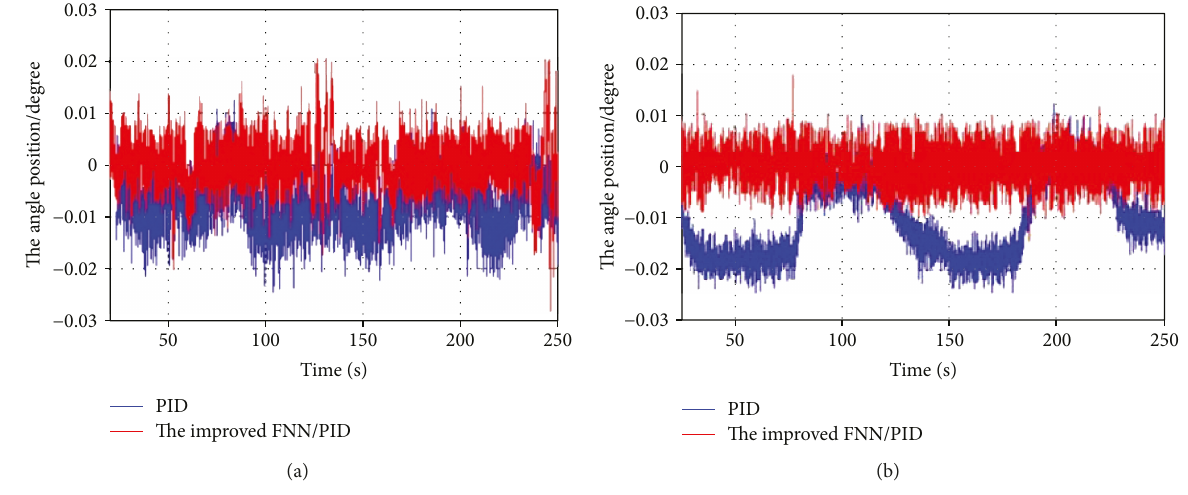
Figure 17: Static levelling experiment results: (a) rolling and (b) pitching. Table 3: Error comparison of static levelling results.